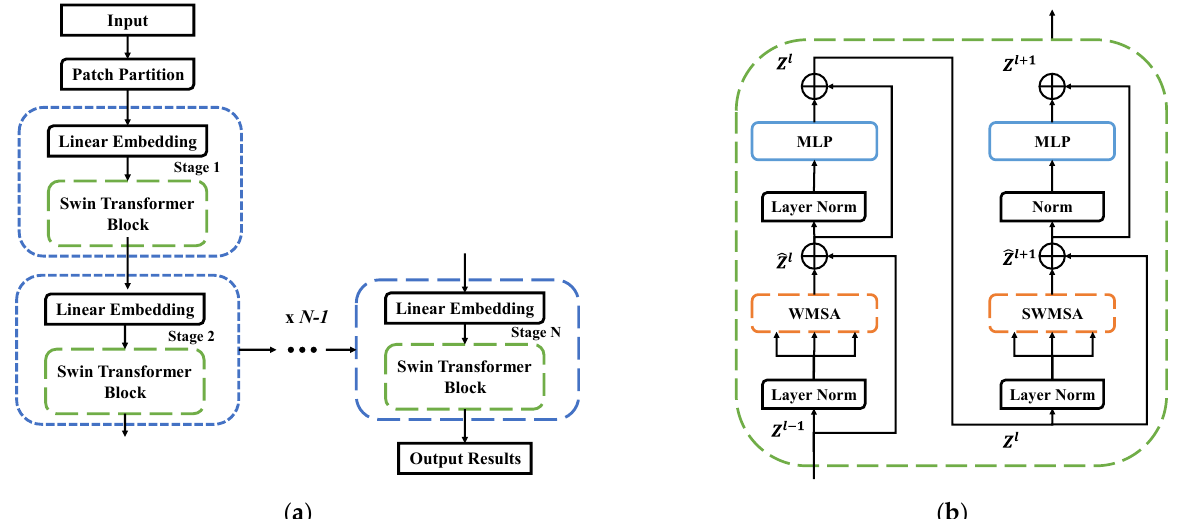
Figure 3. Swin transformer network: ( a ) Network’s structure; ( b ) Swin transformer block. Firstly, the input sample 𝐻 × 𝑊 is divided into patches transformer block extracting the depth features of the containing interdependence. 𝐶 is the number of patch groups divided. Two successive Swin transformer block is shown in Figure 3b. The network’s features are extracted using window multi-head self-attention (WMSA) and shift window multi-head self-attention (SWMSA). Assuming that the input Swin Transformer block feature is 𝑍 𝑙−1 , WMSA output feature Z 𝑙 and multi-layer perceptron (MLP) module output feature 𝑍 𝑙 corresponds to block 𝑙 is shown as follows, respectively: